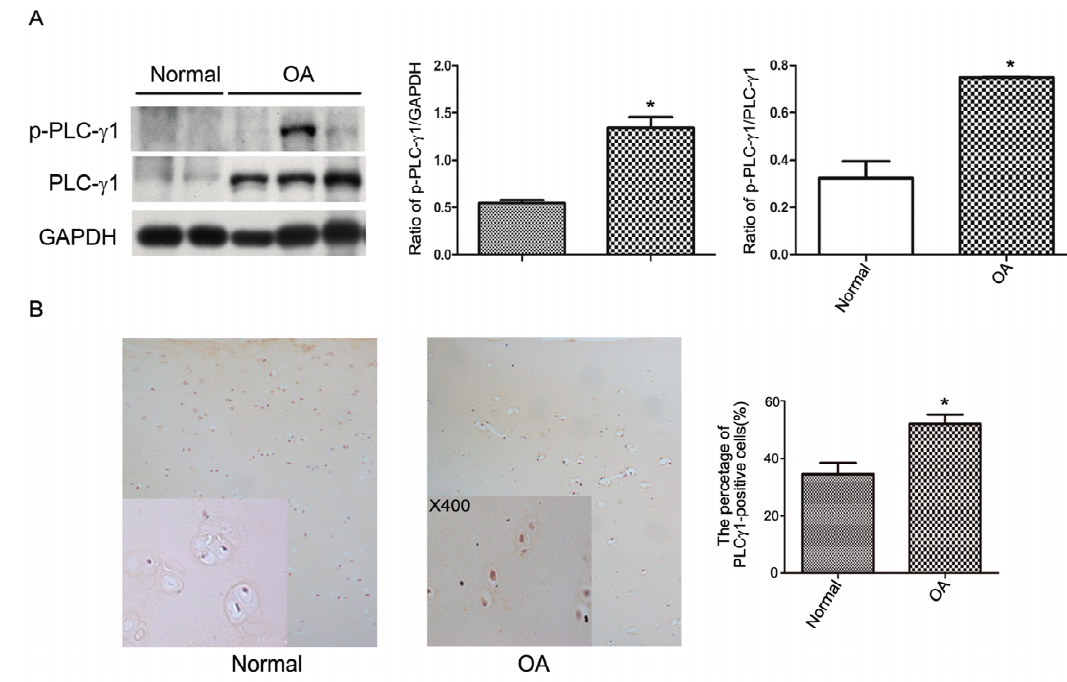
Figure 1. The expression level of phosphoinositide-specific phospholipase γ 1 (PLC γ 1) in normal articular and OA chondrocytes. Normal samples were obtained from 3 patients with amputation from accident, and OA samples were obtained from 20 patients with advanced OA. ( A ) The protein expression levels of PLC γ 1 and p-PLC γ 1 in cultured normal and OA chondrocytes were detected with western blotting analysis using rat anti-PLC- γ 1, p-PLC- γ 1, and GAPDH antibodies according to Materials and Methods. The values represent the mean ±S.E.M. of five independent experiments, each yielding similar results ( * p < 0.05); ( B ) The protein expression level of PLC γ 1 in normal articular and OA cartilage was detected with immunohistochemistry analysis according to Materials and Method (original magnification ×100 or ×400, * p <